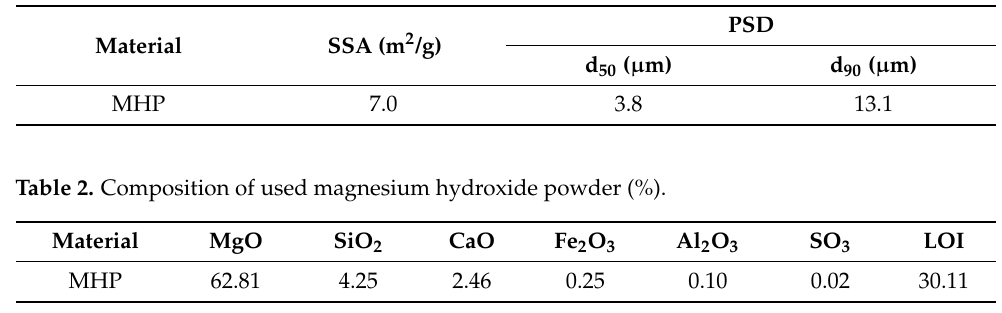
Table 1. The Specific Surface Area (SSA) and the Particle Size Distribution (PSD) of used magnesium hydroxide powder (MHP).